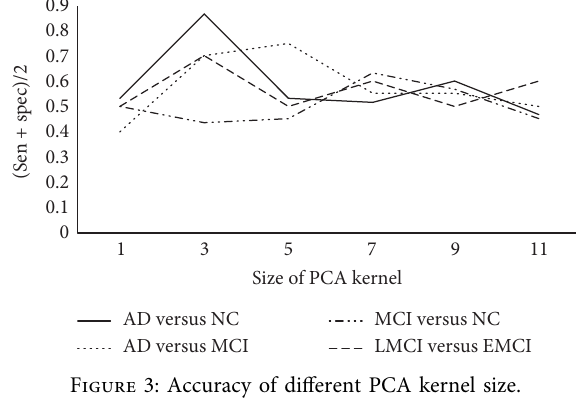
Figure 3: Accuracy of different PCA kernel size.